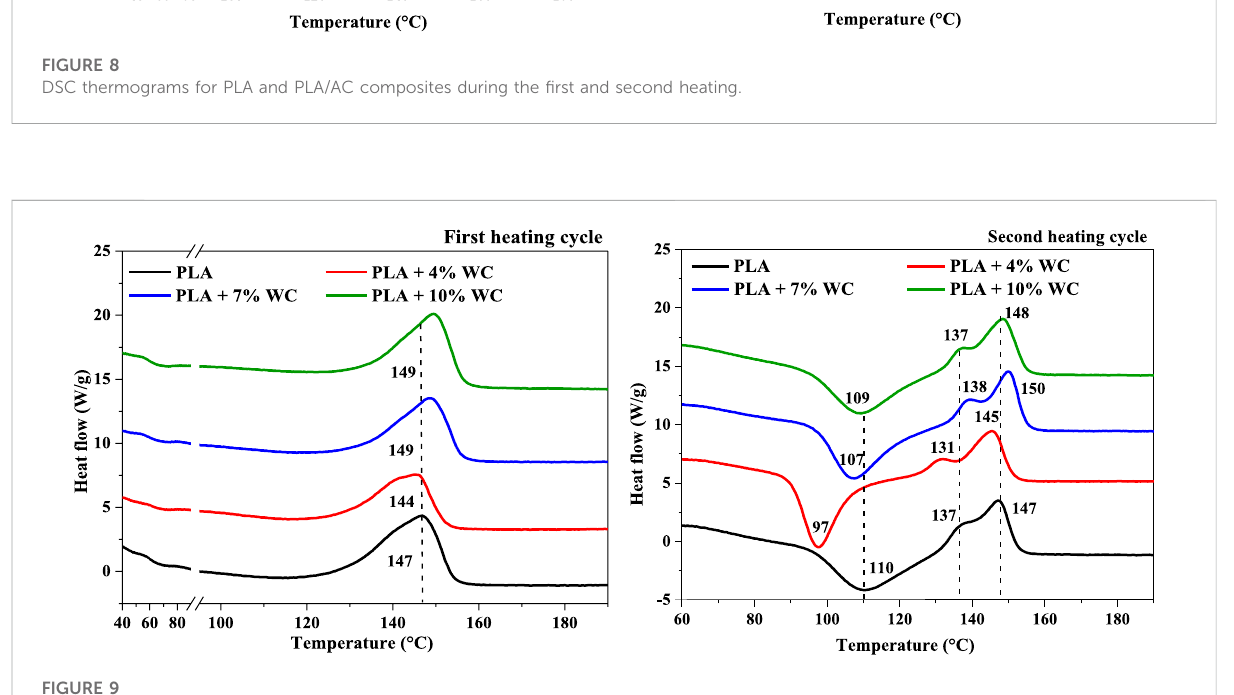
FIGURE 9 DSC thermograms for PLA and PLA/AC composites during the fi rst and second